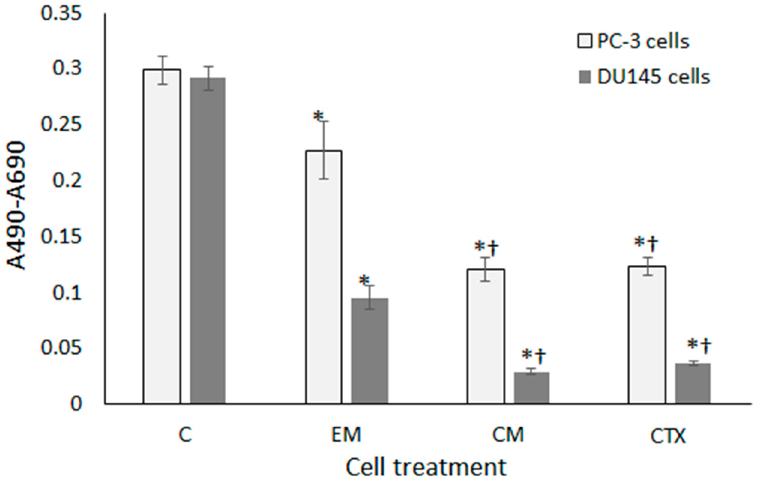
Figure 10. Growth of prostate cancer cells in the presence of nanofibers (direct contact), assessed using the SRB assay; (C) control; (EM) drug-free mat; (CM) CTX-loaded mat; (CTX) 10 nM CTX solution. Cells were incubated with patches for 3 days; results are shown as mean ± SD; * p < 0.05 compared to control; † p < 0.05 compared to the empty mat (ANOVA).